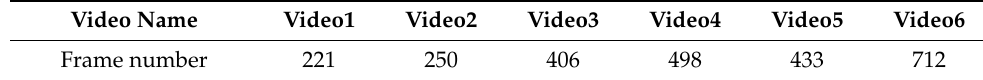
Table 1. The frame number of each video in our dataset.